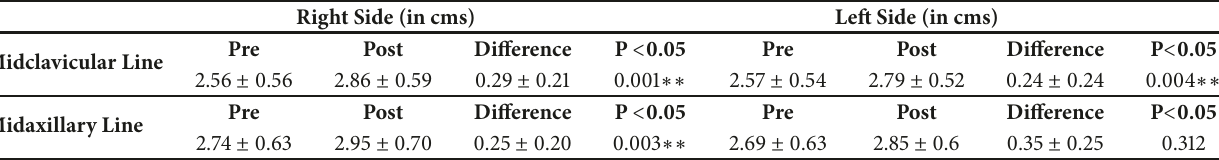
Table 2: Comparison of Diaphragmatic Excursion before and after Diaphragmatic Stretch Technique. Right Side (in cms)